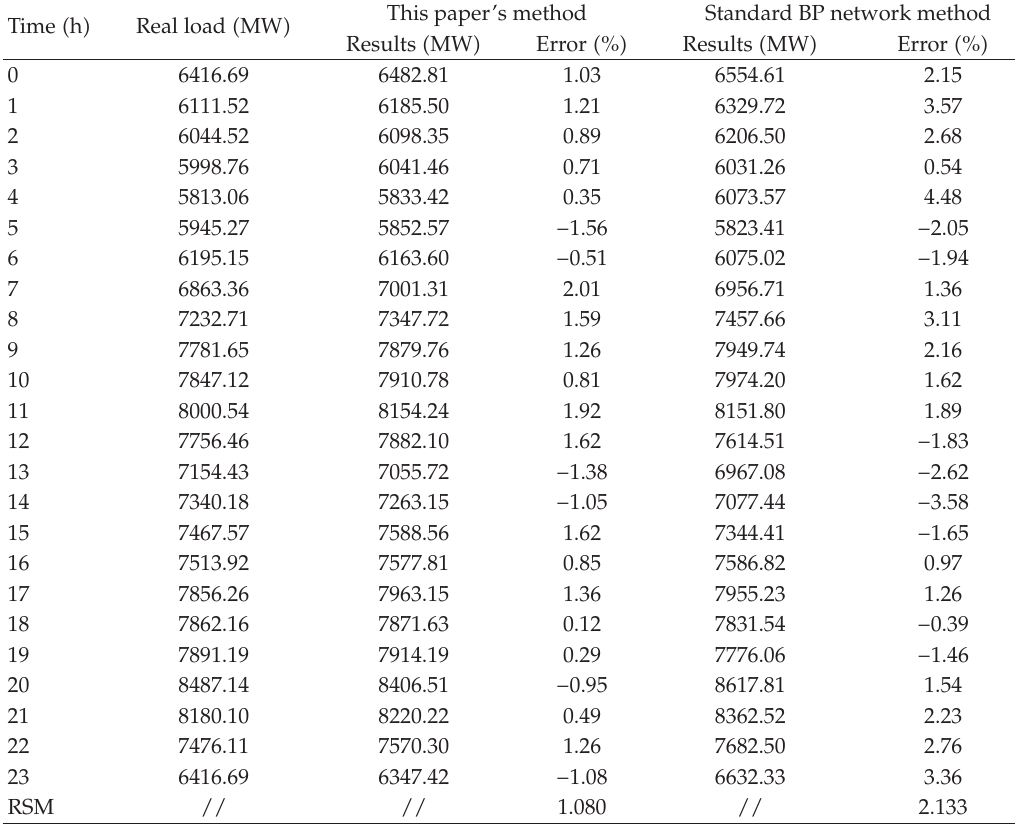
Table 1: Comparison of the forecasting results and errors by the di ff erent